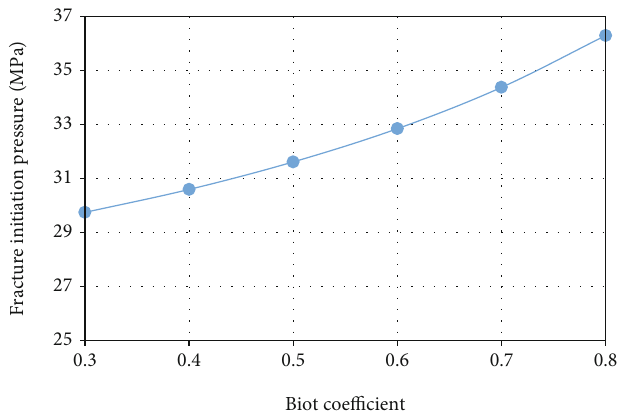
Figure 15: FIP with di ff erent Biot coe ffi cient.